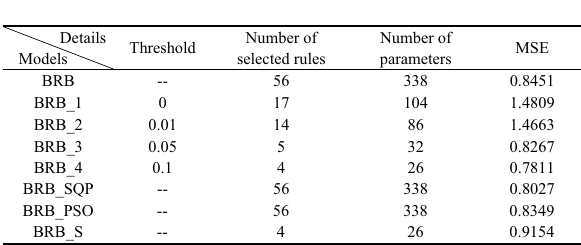
Table 14. The details and final testing results generated by different BRBs.